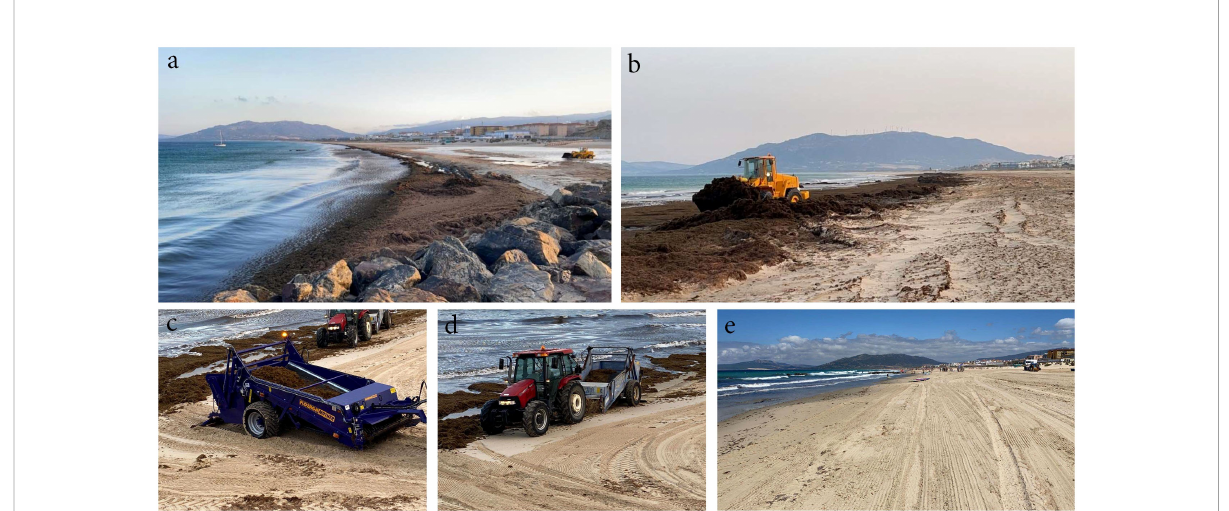
FIGURE 2 Mechanical removal of R. okamurae beachings on Los Lances and Atlanterra beaches (Tarifa, Spain) during the 2021 summer (A-D) R. okamurae beaching and its removal with heavy machinery (6.213 tons in only two months); (E) the same beach after seaweed removal. Photos and data provided by the City Council of